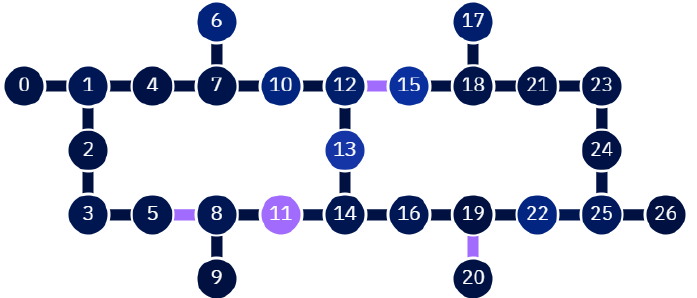
Figure 10. Architecture of the IBM_hanoi quantum computer. The C-NOT connectivity is reported. The colors of single qubits and their connections represent, respectively, the single qubit readout assignment error and C-NOT error probabilities. Darker colors represent a lower error probability, in a range between 5.9 × 10 − 3 and 9.8 × 10 − 2 for the readout error and 3.3 × 10 − 3 and 1 for C-NOT gates. Data from calibration on 19 October